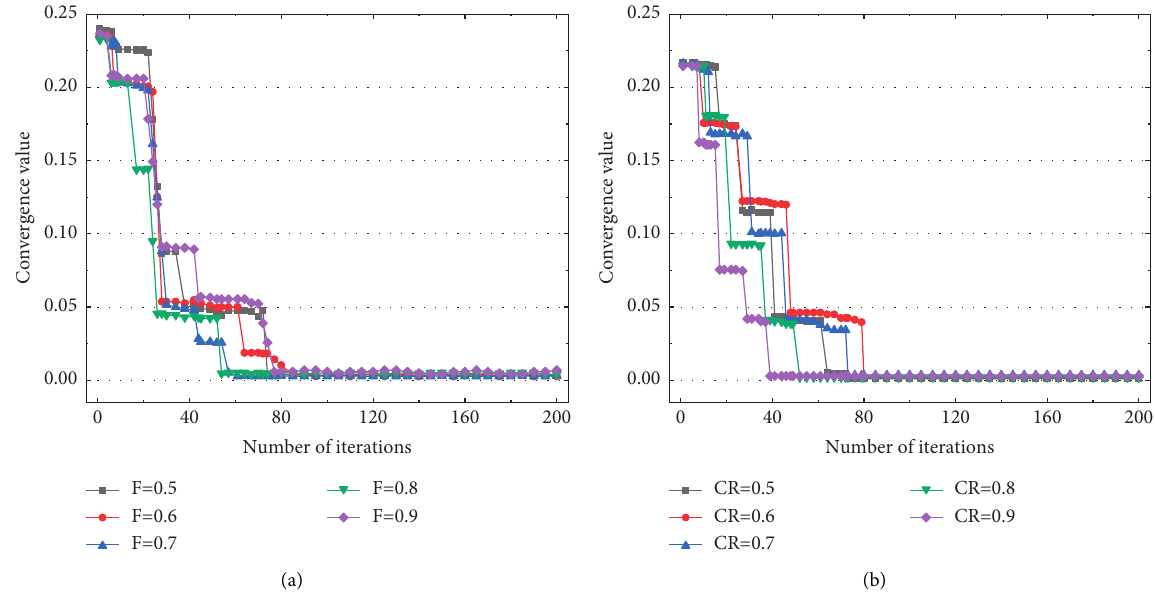
Figure 9: Iterative curves of different variation factors and crossover factors. (a) When CR � 0.7, iterative curves of different variation factors F . (b) When F � 0.8, iterative curves of different crossover factors CR.